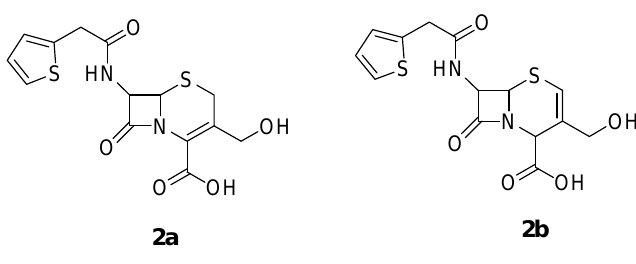
Figure 2. Hydroxymethylcephalothin